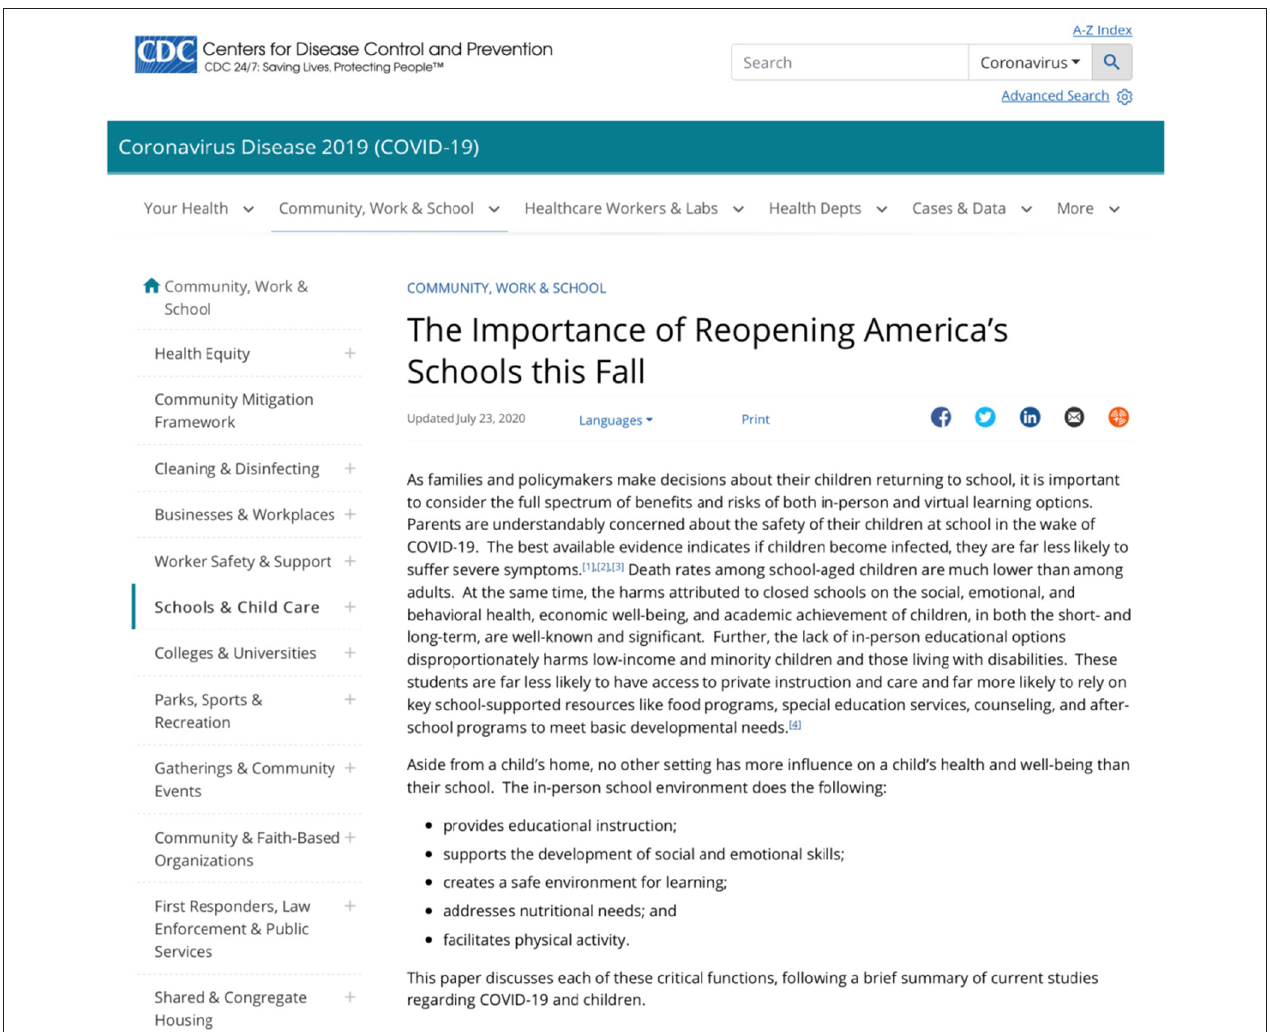
FIGURE 2 | Screenshot of the CDC website featuring the Statement on The Importance of Reopening America’s Schools this Fall